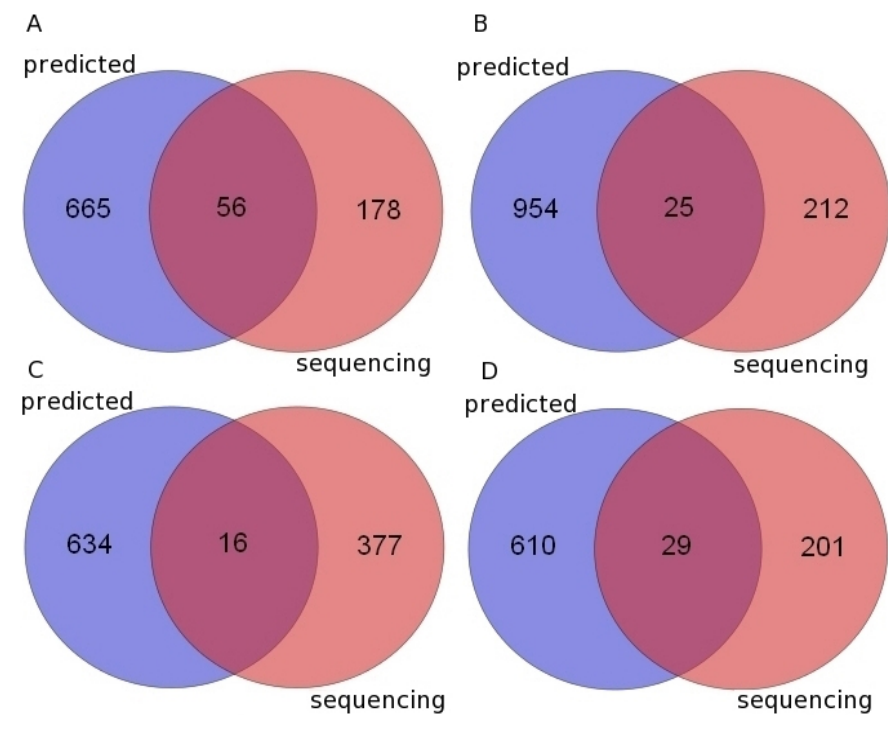
Figure 1. The Venn diagrams of miRNAs identified by using a comparative genomics approach and small RNA sequencing data. ( A ) Chimpanzee; ( B ) Gorilla; ( C ) Orangutan; ( D ) Rhesus macaque. Predicted: miRNAs which were predicted by using a comparative genomics approach. Sequencing: miRNAs which were identified from small RNA sequencing